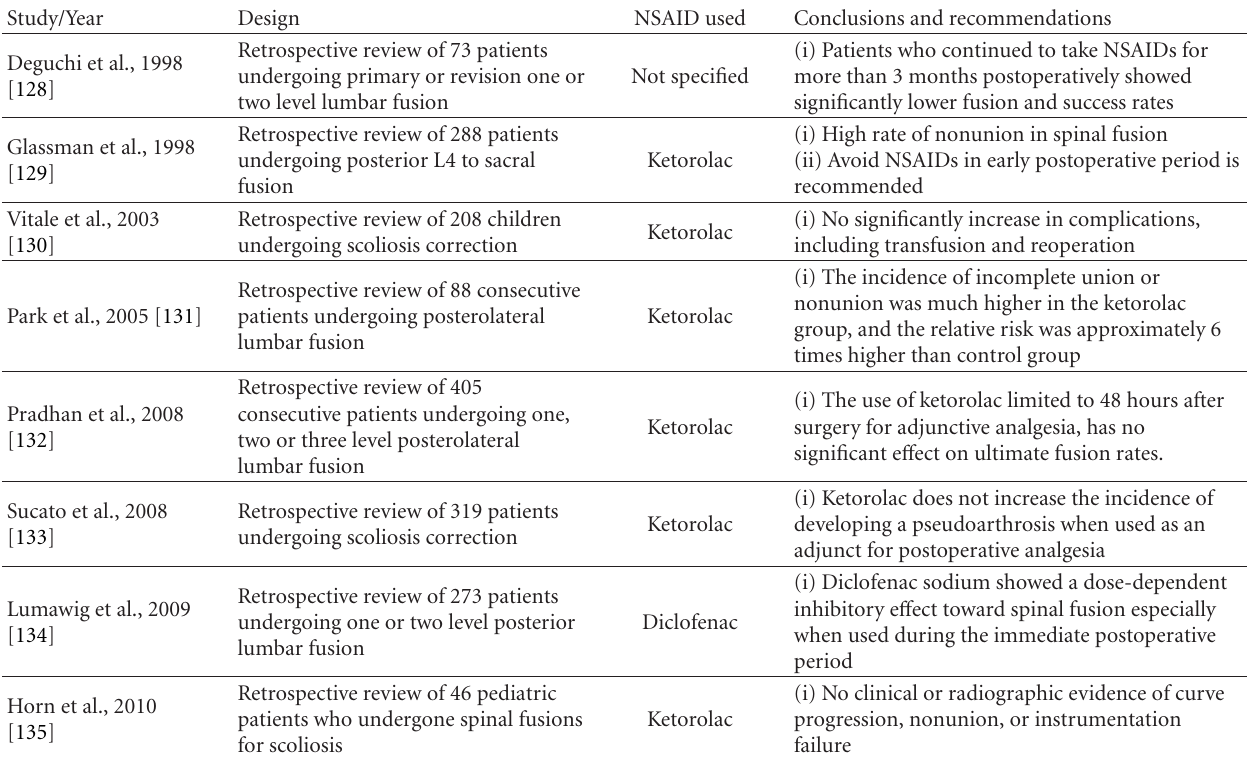
Table 3: The e ff ect of NSAIDs on spinal fusion in